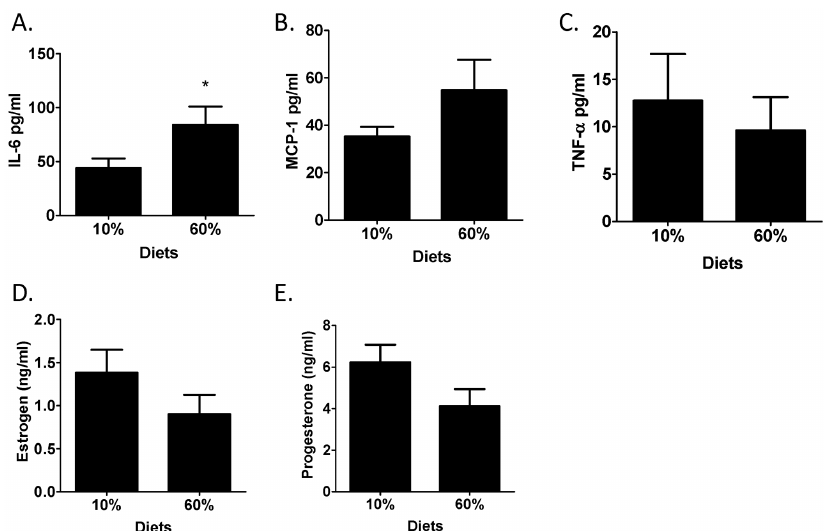
Figure 3. IL-6 concentration was elevated but plasma levels of other inflammatory mediators and reproductive hormones were not increased by obesity in parous mice. Cytokine and chemokine concentrations of A) IL-6, B) TNF- a and C) MCP-1 were measured in plasma at sacrifice. n=12. *P=0.028. D) Plasma estrogen levels were determined using ELISA analysis. n=14. E) Plasma progesterone levels were determined using ELISA analysis. n=14.